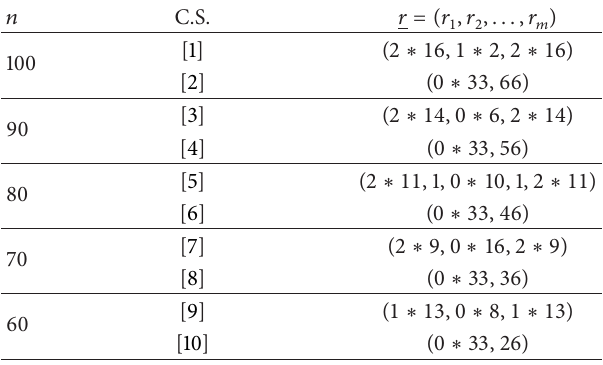
Table 1: Progressively Type II censoring schemes (C.S.) applied in the simulation study ( 𝑏 = 25 , 𝑚 = 35 , and 𝑡 = 0.04 ).